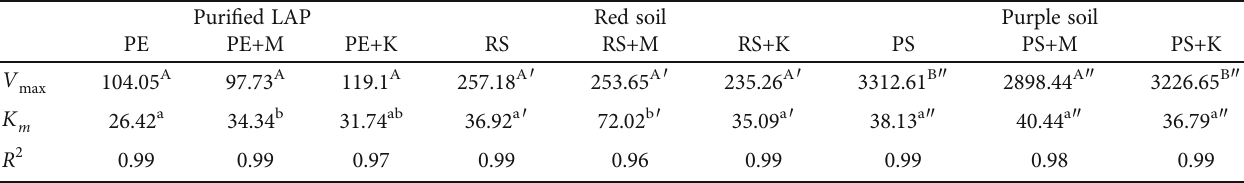
and K m ) of LAP by montmorillonite and kaolinite. max